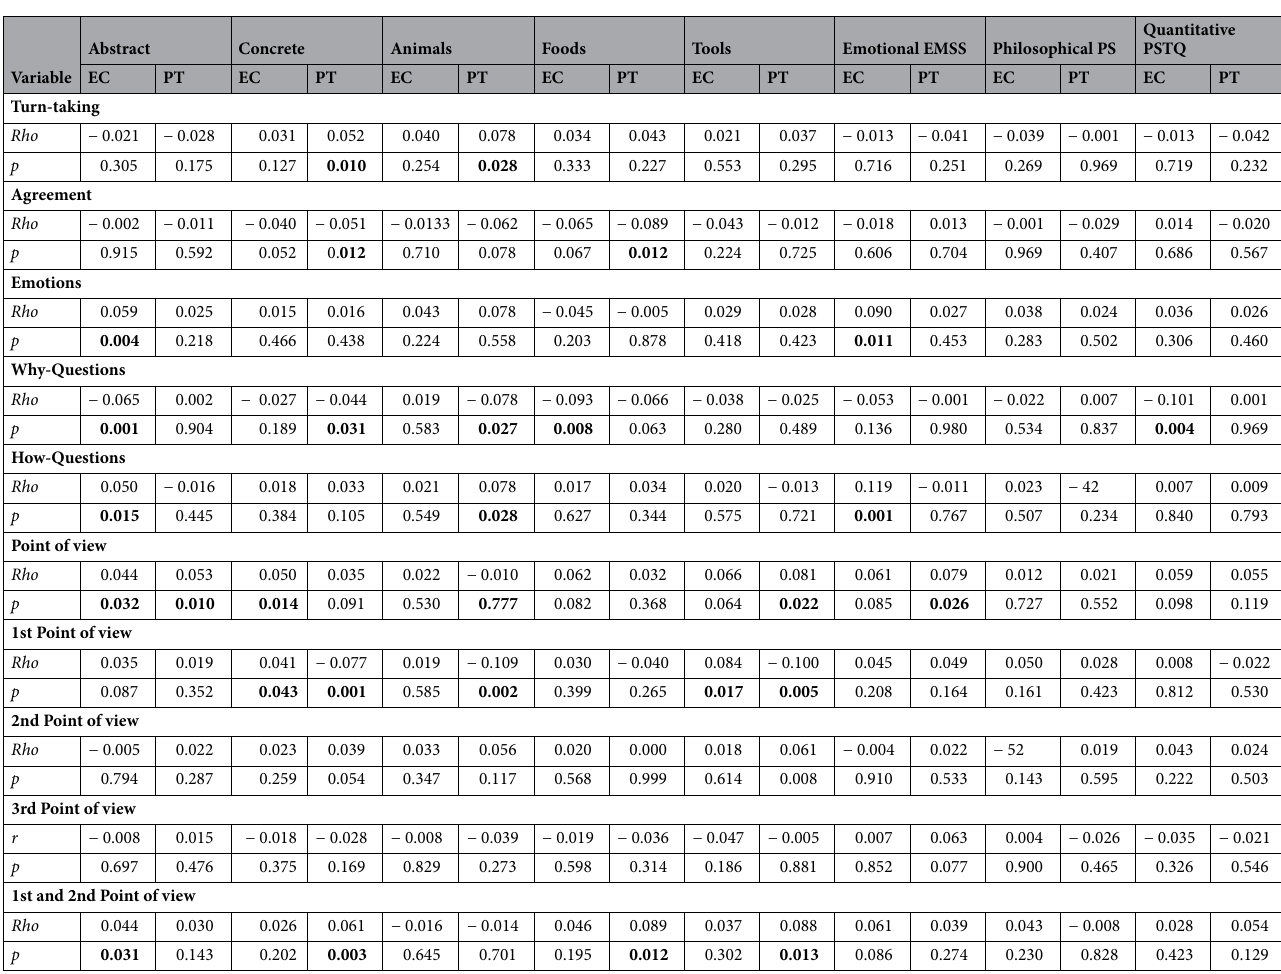
Table 3. Spearman rank correlation between the empathic concern (EC) and perspective-taking (PT) subscale for the selected variables across abstract and concrete sentences and sub-type of concrete sentences